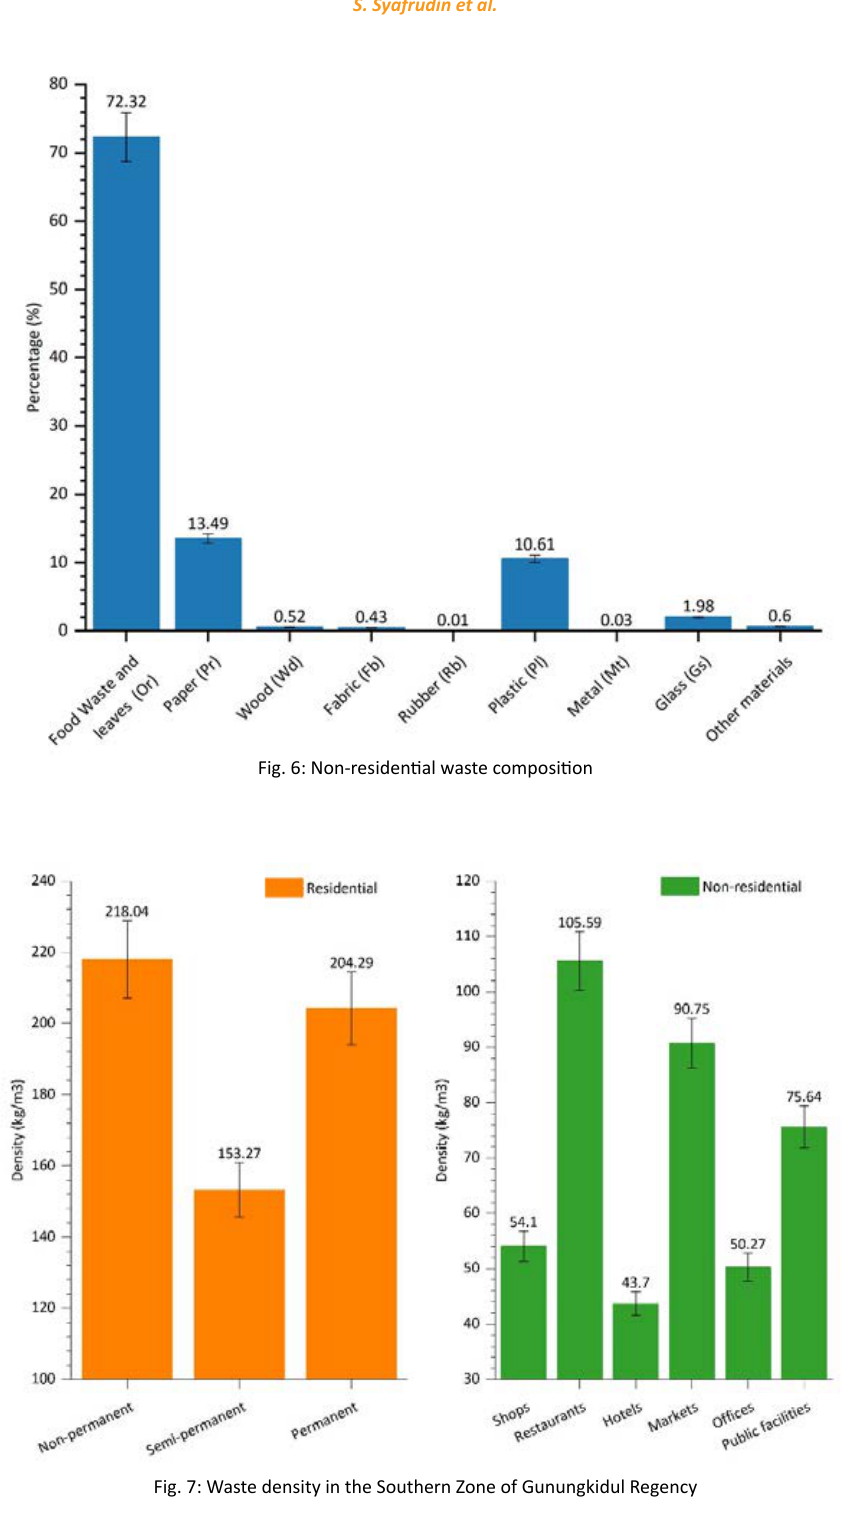
Fig. 7: Waste density in the Southern Zone of Gunungkidul Regency